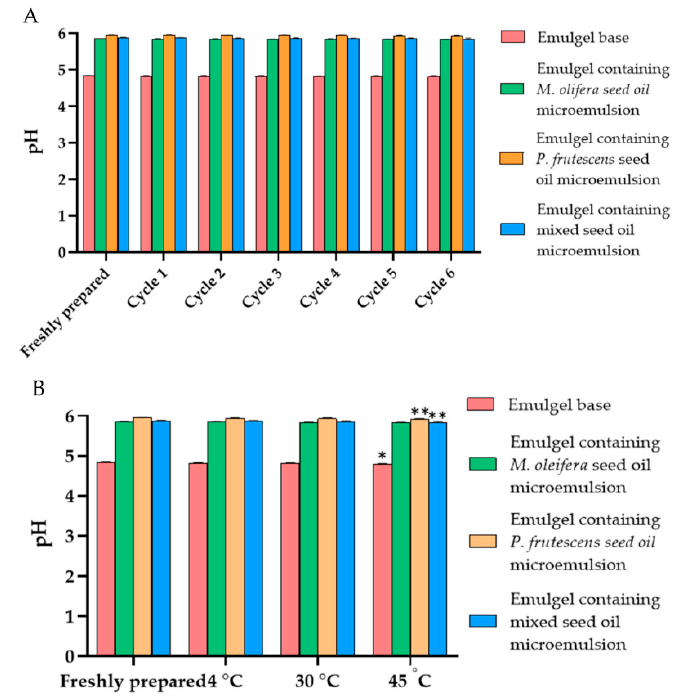
Figure 8. ( A ) pH values of emulgel base, emulgel containing P. frutescens , M. oleifera , and mixed seed oil microemulsion after six heating–cooling cycles stability tests. ( B ) pH values of emulgel base and emulgels containing P. frutescens , M. oleifera , and mixed seed oil microemulsion after storage at 4 °C, 30 °C, and 45 °C for 1 month. Data represent mean ± SD from three experiments. * indicates p < 0.05, and ** indicates p < 0.01, compared with freshly prepared emulgel.